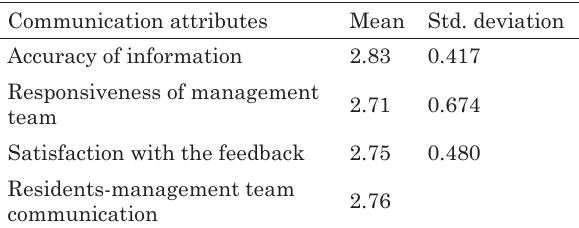
Table 3. Effective communication Communication attributes Mean Std. deviation